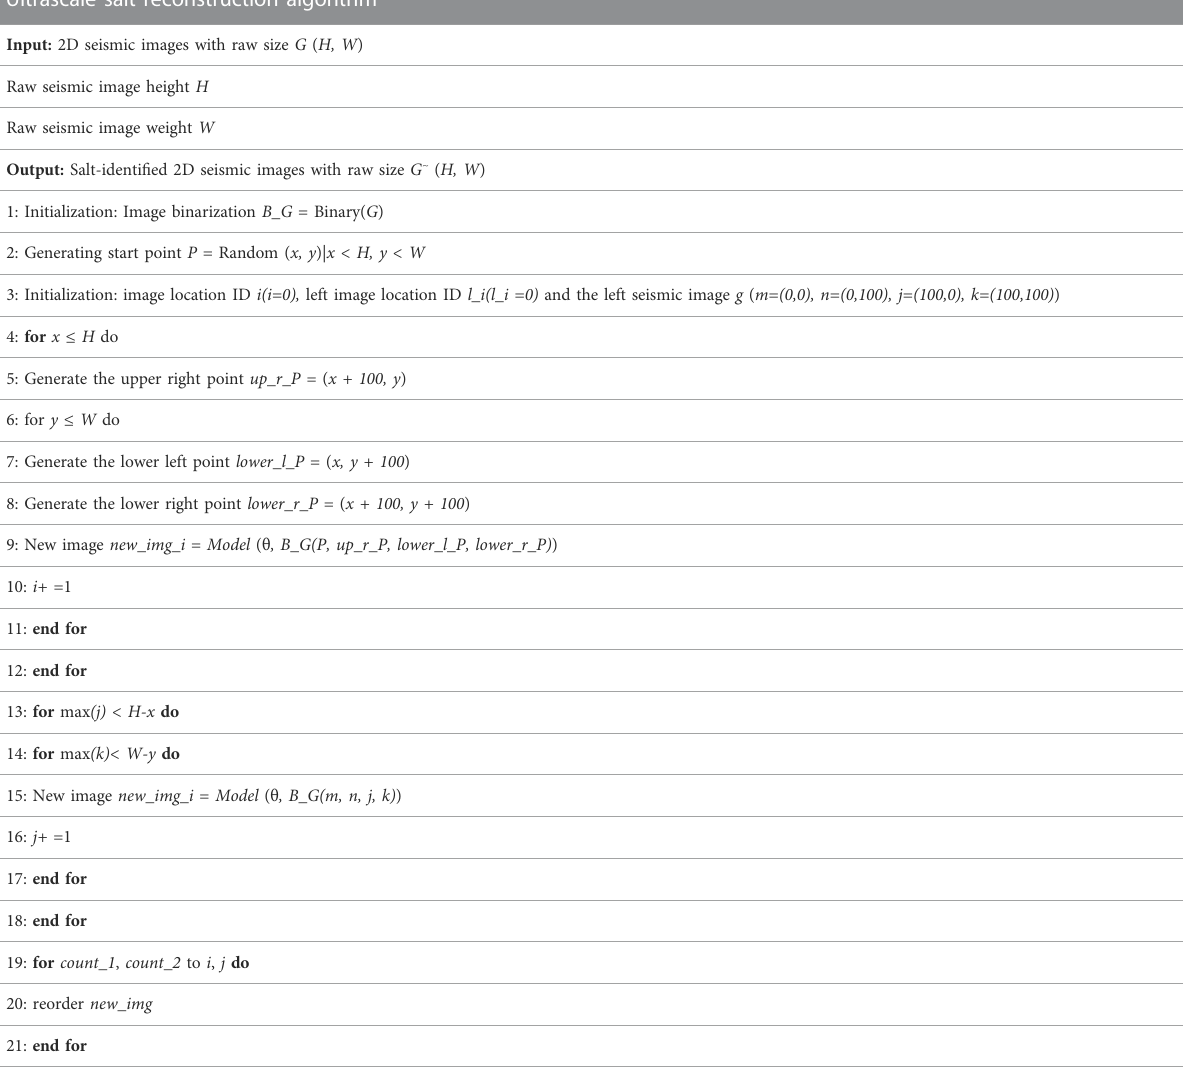
Raw seismic image height